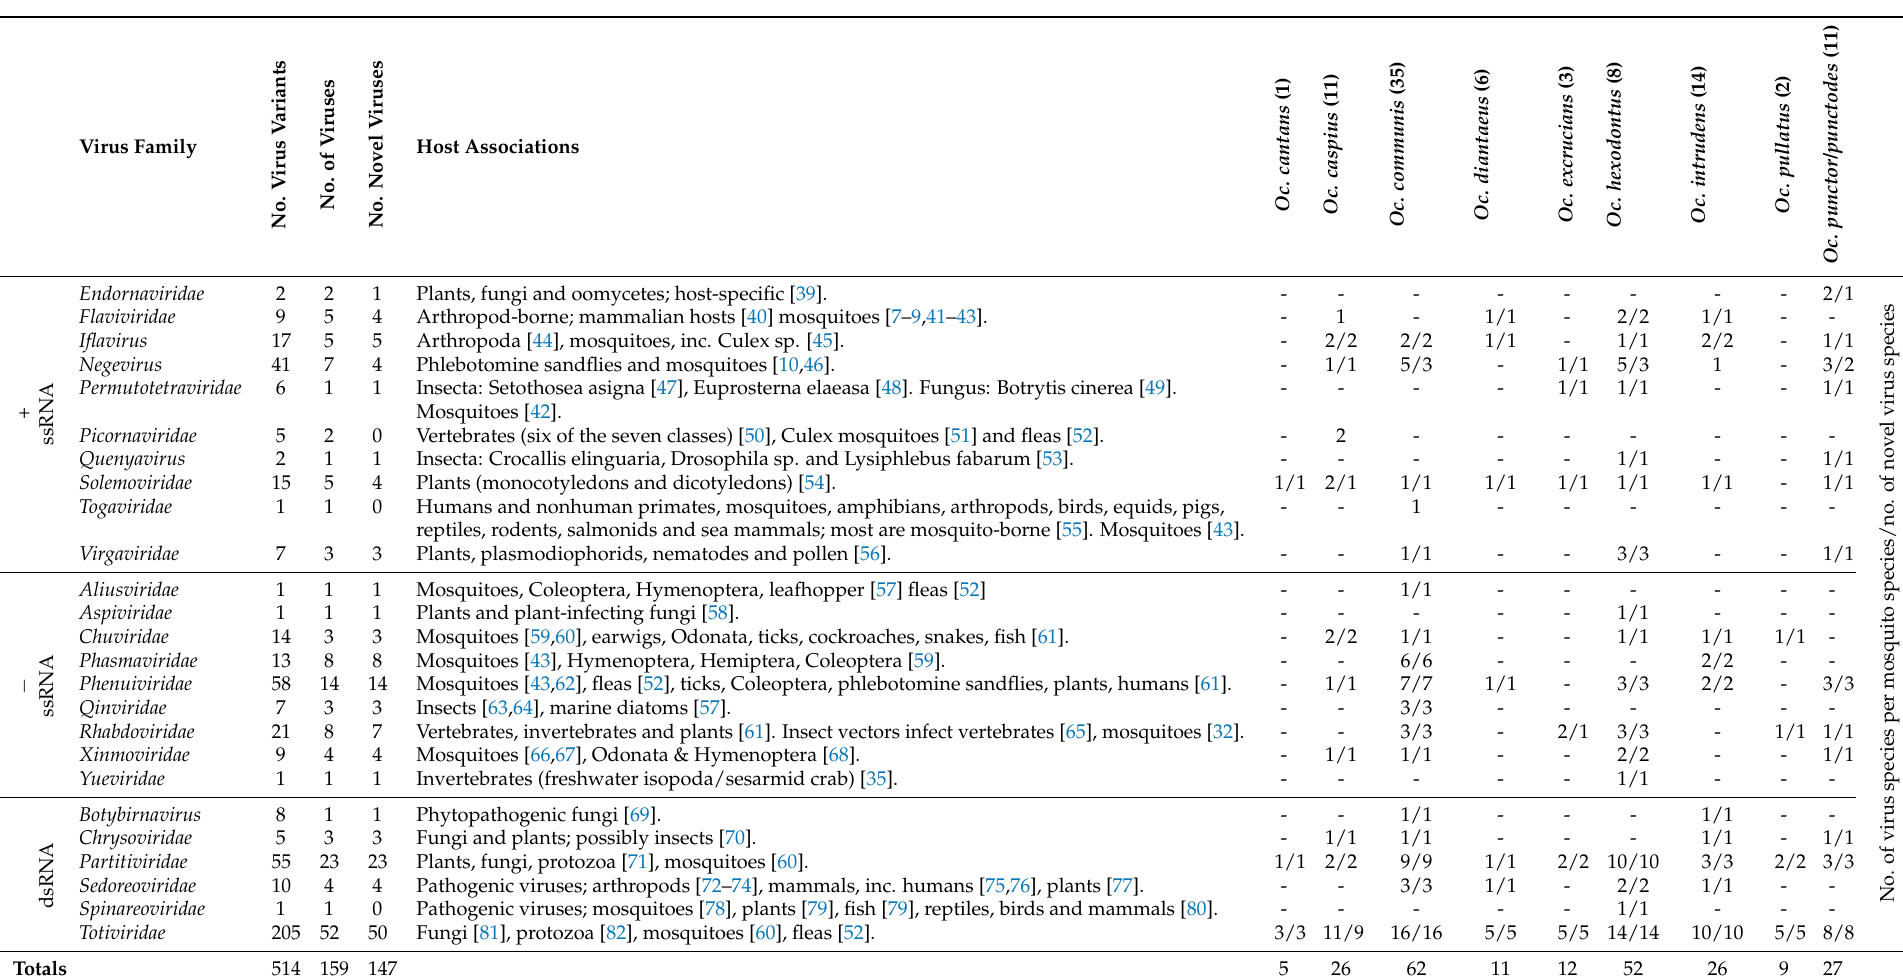
Table 8. Virus families detected by NGS, their host/vector associations and the (number of virus species/novel virus variants) by mosquito species. Brackets next to mosquito species names denotes the number of pools studied. Where a single digit is given, no novel viruses were detected for the given virus family/mosquito.